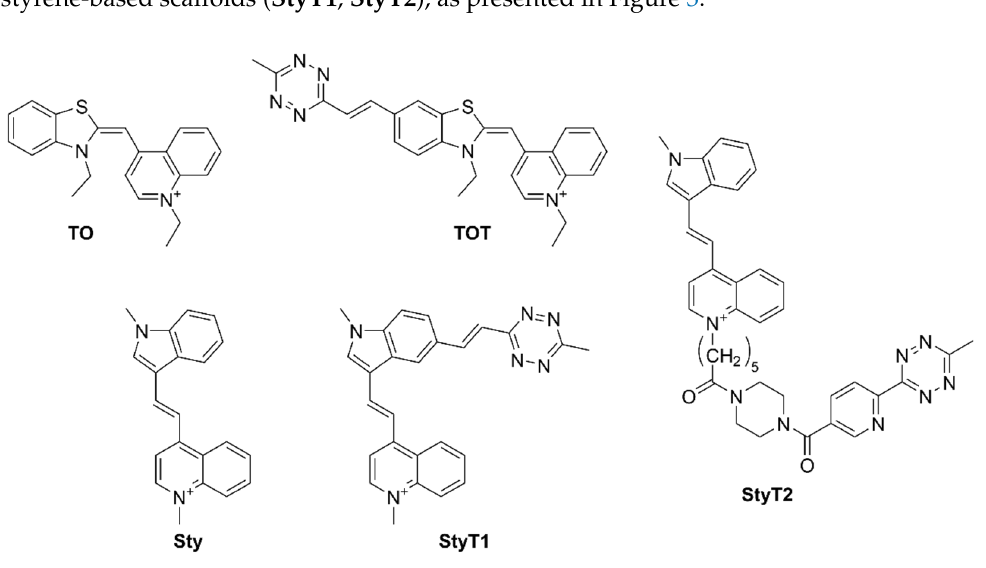
Figure 3. The structures of TO and Sty frames and their tetrazine modified derivatives.